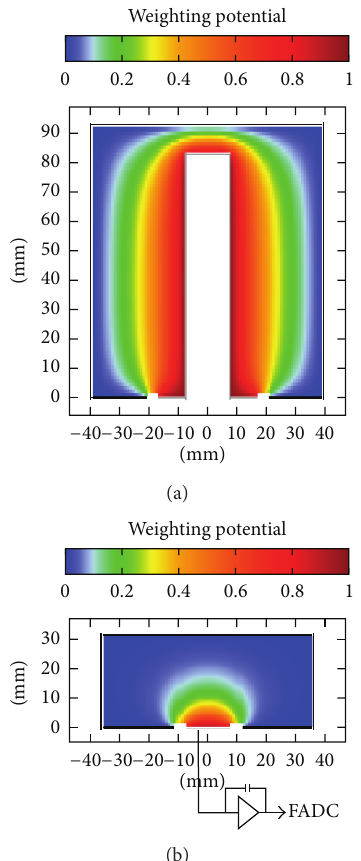
Figure 2: Cross-section of a semicoaxial detector (a) and a BEGe detector (b). The n + electrode is drawn in black and the p + electrode in gray; the thicknesses are not to scale. The two electrodes are separated by an insulating groove. The weighting potential [29] inside the detectors is indicated through a color map. For the BEGE also the readout with a charge sensitive amplifier is shown. From [32].